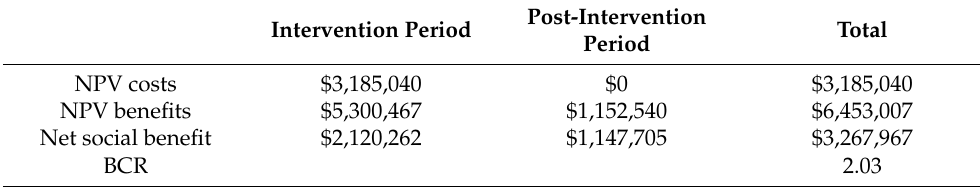
Table 2. Economic benefit of the BackTrack program.